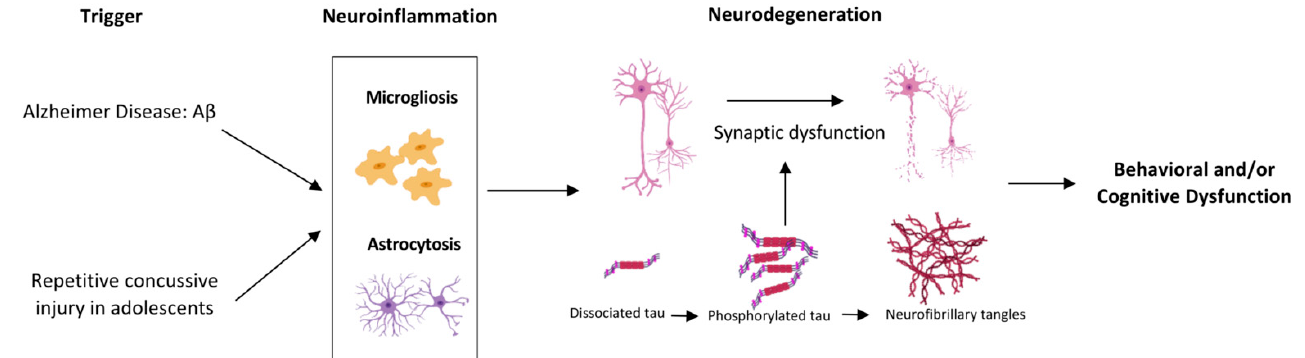
Figure 5. Proposed parallel mechanism between Alzheimer’s disease and Repetitive Concussive Injury. Our observation of increased microglia and astrocytes post rCHI in P301S mice in the absence of tau pathology and behavioral dysfunction or neuronal loss points to a potential parallel mechanism to that observed in Alzheimer’s disease where the inflammatory response develops likely as a result of Amyloid β deposition and thereafter contributes to the development of tau pathology and cognitive dysfunction. It is possible that recurrent concussion, similar to Amyloid β deposition is the initial trigger for a similar cascade of events. Created with BioRender.com.